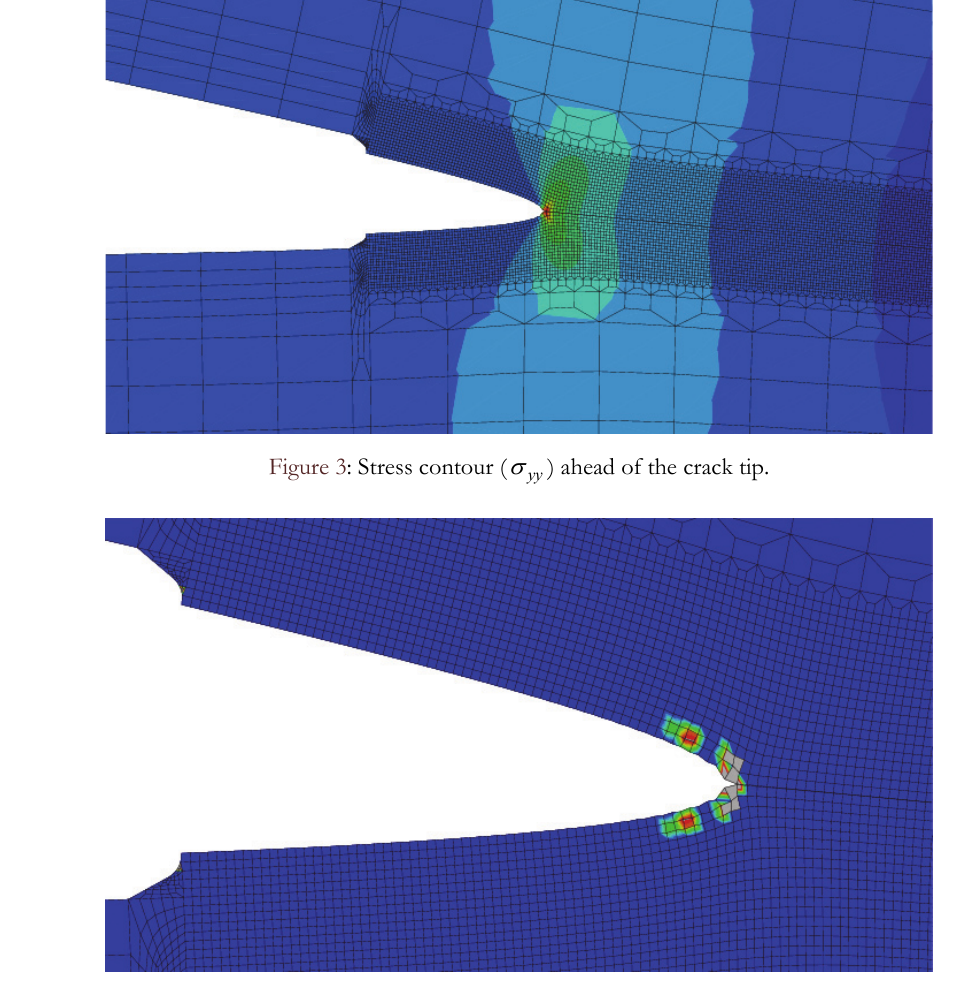
Figure 4: Contour of equivalent plastic